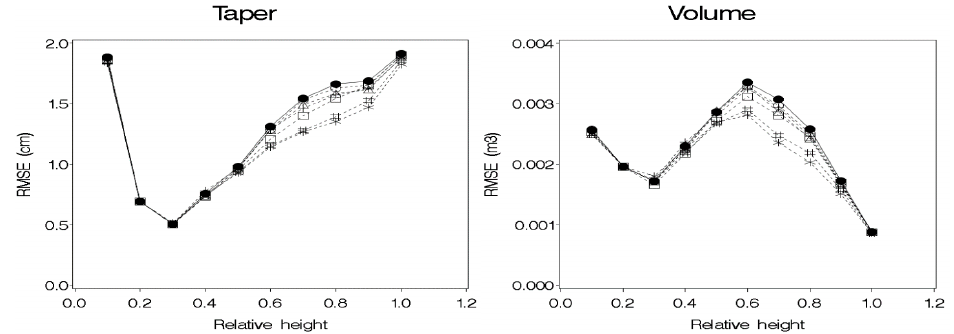
Figure 2. Root mean square error (RMSE) by relative height classes for diameter and volume predictions using Clark model with and without crown variables for Dahurian larch.